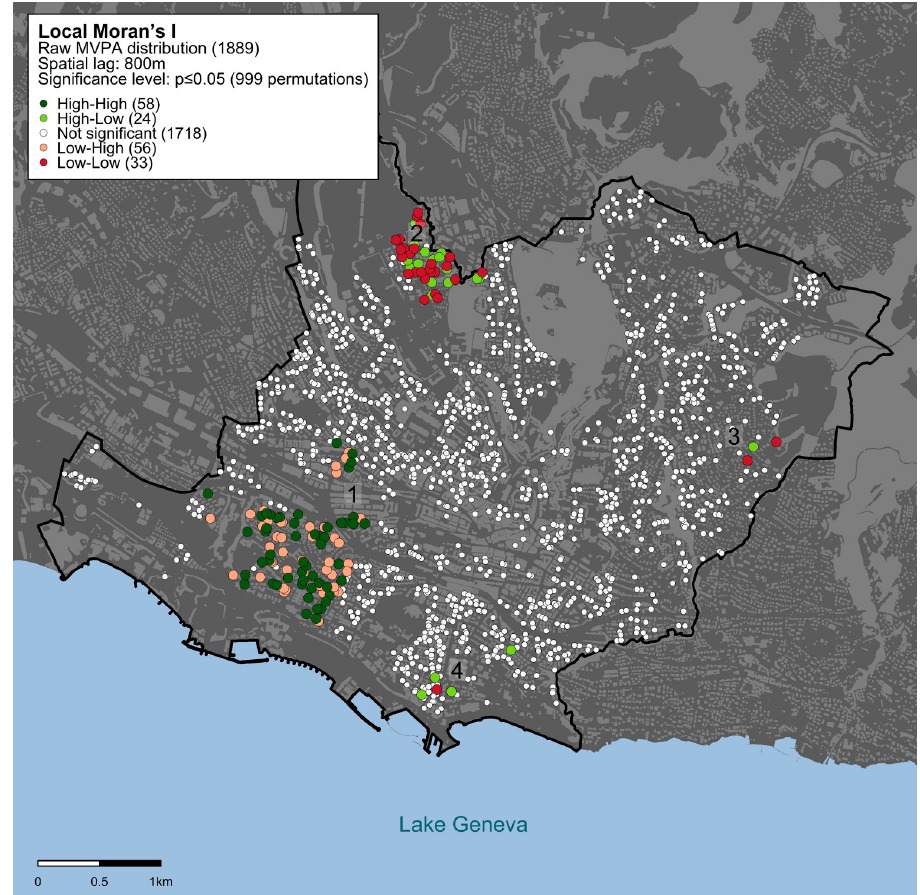
Fig 2. Spatial clusters of MVPA adjusted for socioeconomic and demographic factors using Local Moran’s I statistics. Statistical significance is assessed based on an α threshold of p < 0.05 within a spatial lag of 800 m. Dark- green dots indicate individuals with high MVPA values surrounded by neighbors also showing high MVPA values; red dots indicate individuals with low MVPA surrounded by neighbors with low MVPA values; light-green dots indicate individuals with high MVPA values surrounded by neighbors showing low MVPA values; pink dots indicate individuals with low MVPA values surrounded by neighbors with high MVPA values; white dots indicate individuals whose MVPA values are randomly distributed in the geographic space. Landmarks (1–4) are shown to facilitate the description and interpretation of the result. Map was created using data from the Swiss Federal Office of Topography